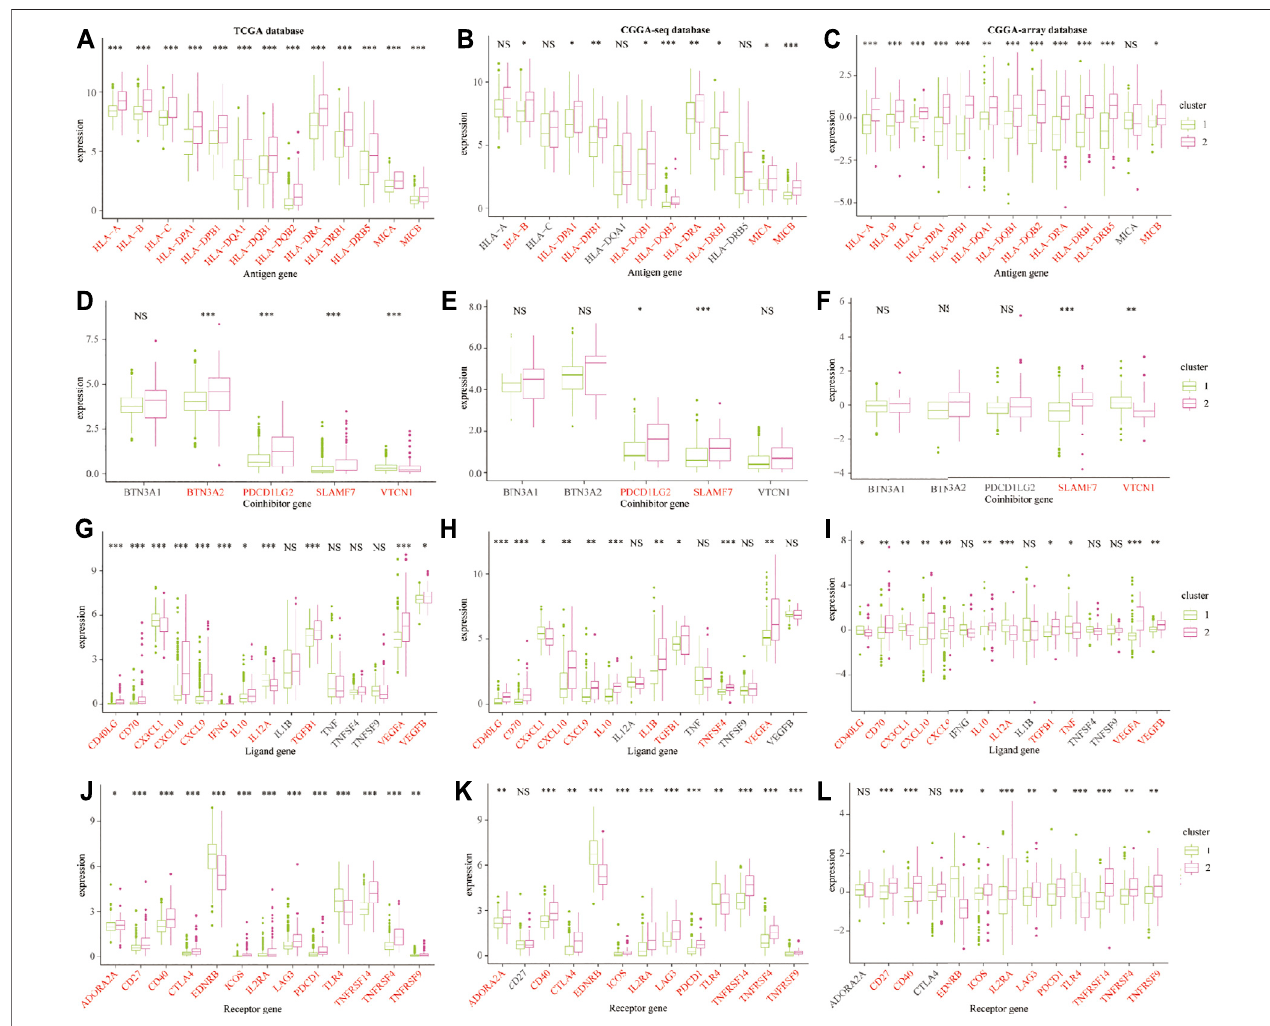
FIGURE6| Theimmune escape-associated geneexpression incluster1and cluster 2fromthetrainingand validationcohorts. Theexpression ofantigen genesin cluster1andcluster2fromtheTCGA (A) ,CGGA-sequence (B) ,andCGGA-array (C) databases.Theexpressionofco-inhibitorygenesincluster1andcluster2fromthe TCGA (D) ,CGGA-sequence (E) ,andCGGA-array (F) databases.Theexpressionofligandgenesincluster1andcluster2fromtheTCGA (G) ,CGGA-sequence (H) ,and CGGA-array (I) databases. The expression of receptor genes in cluster 1 and cluster 2 from the TCGA (J) , CGGA-sequence (K) , and CGGA-array (L) databases. * p < 0.05, ** p < 0.01, *** p < 0.001, NS, no signi fi cant differences.